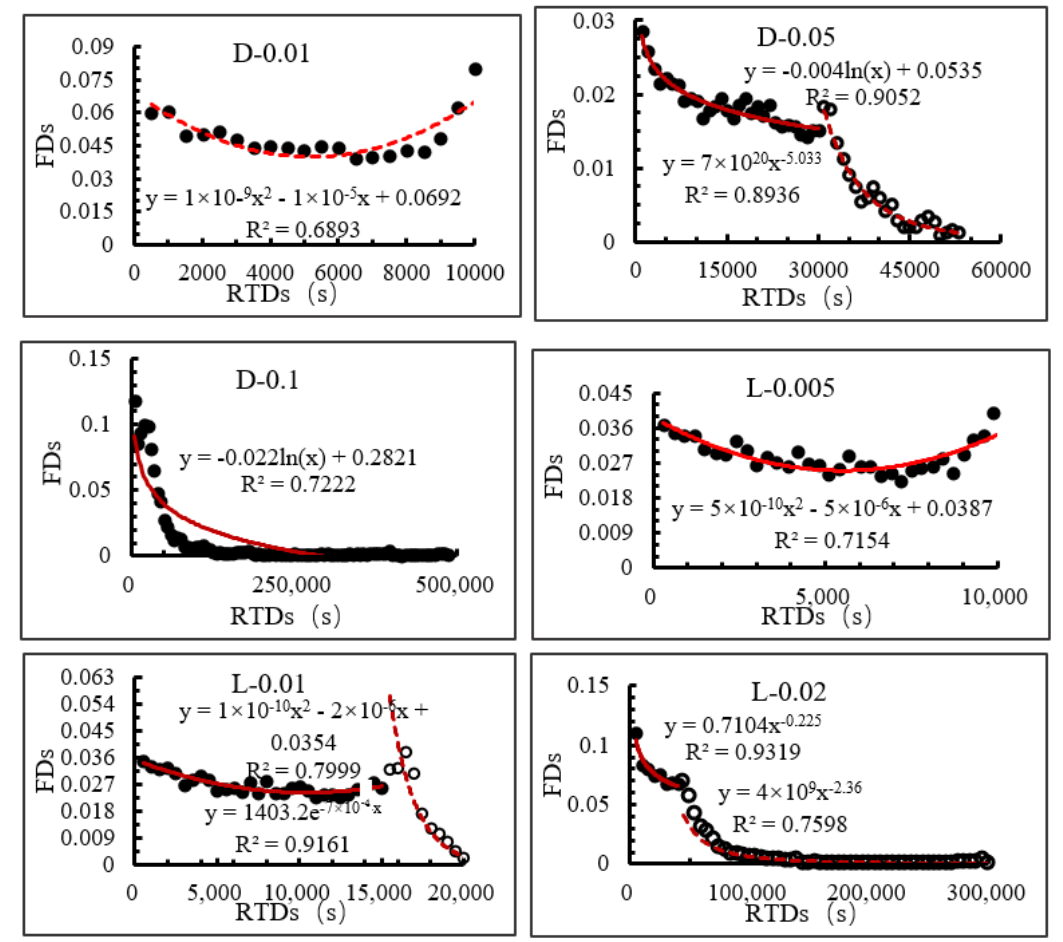
Figure 12. Frequency distribution of RTDs of artificially recharged water (injection well IW1) with different decay direction and decay exponents of hydraulic conductivity. “D-0.01” means the depth-decay exponent was set to 0.01, and “L-0.005” means the length-decay exponent was set to 0.005. The red lines are fitted trend lines.